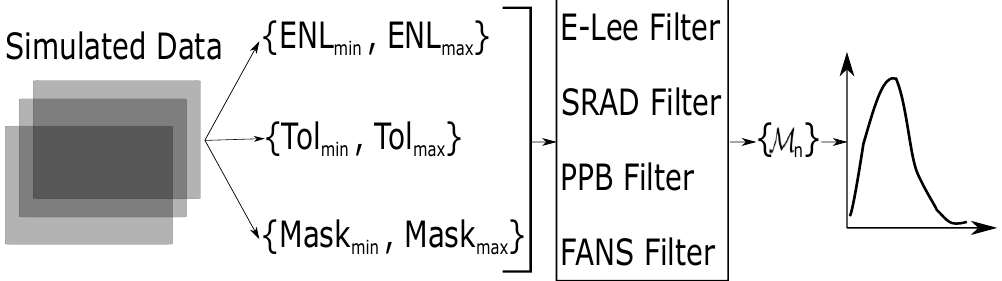
Figure 4. Monte Carlo experiments to infer about the distribution of